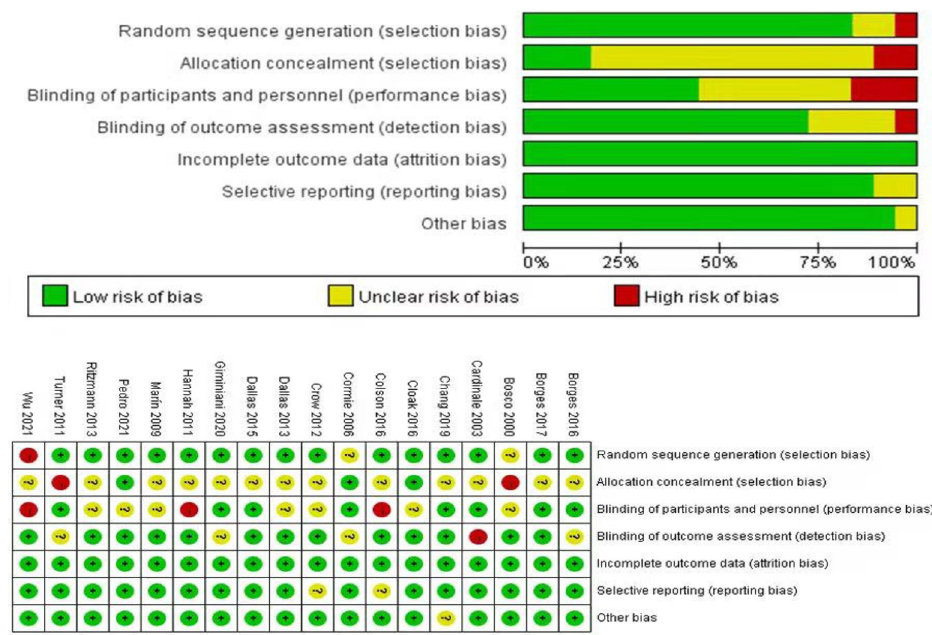
Fig 2. Methodological quality assessment of the included studies with Cochrane scale.